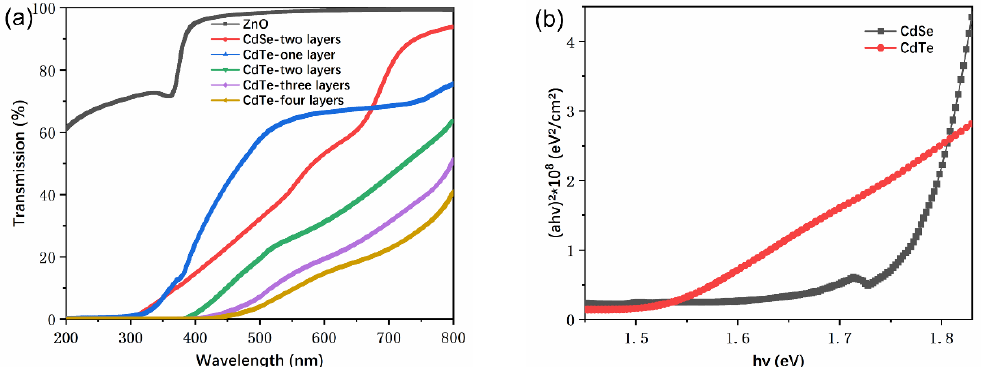
Figure 2. ( a ) Transmission spectra of different ZnO, CdSe NC thin films and CdTe NC thin films with different thicknesses; ( b ) the plots of ( αhv ) 2 versus photon energy ( hv ) of the CdSe and CdTe NC thin films.